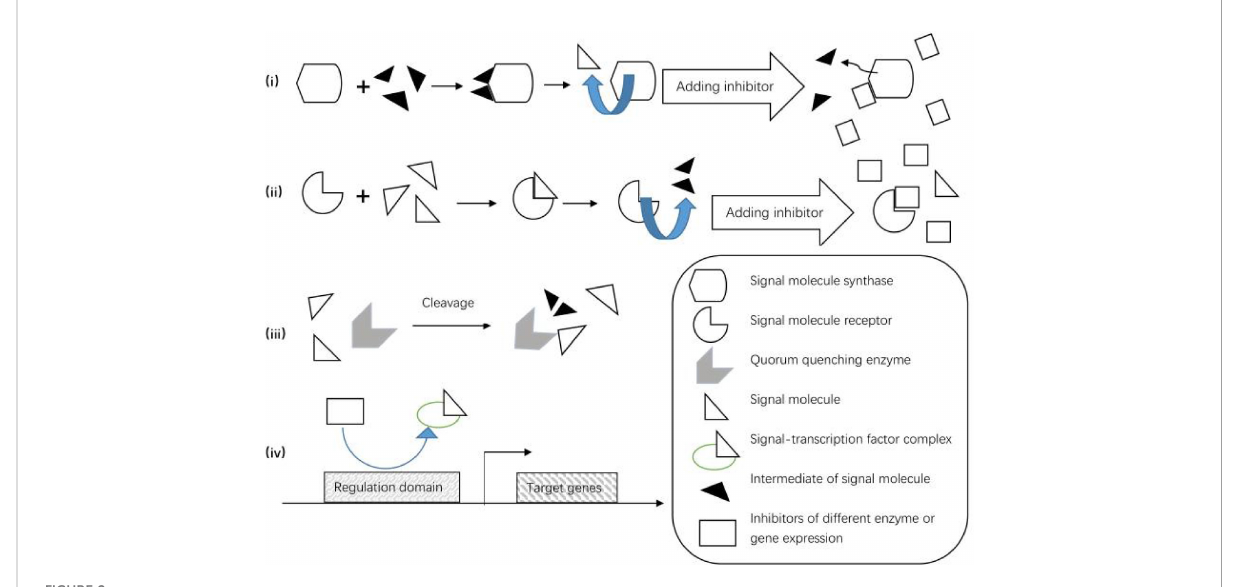
FIGURE 2 Mechanisms of quorum quenching, including signal production, perception and transmission through competitive inhibition or signal degradation, and inhibition of QS-related gene